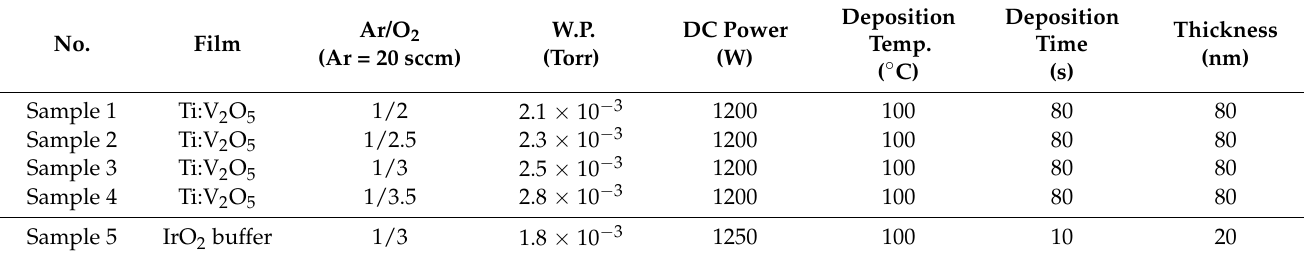
Table 1. Deposition parameters of IrO 2 buffer on Ti:V 2 O 5 counter electrode films.